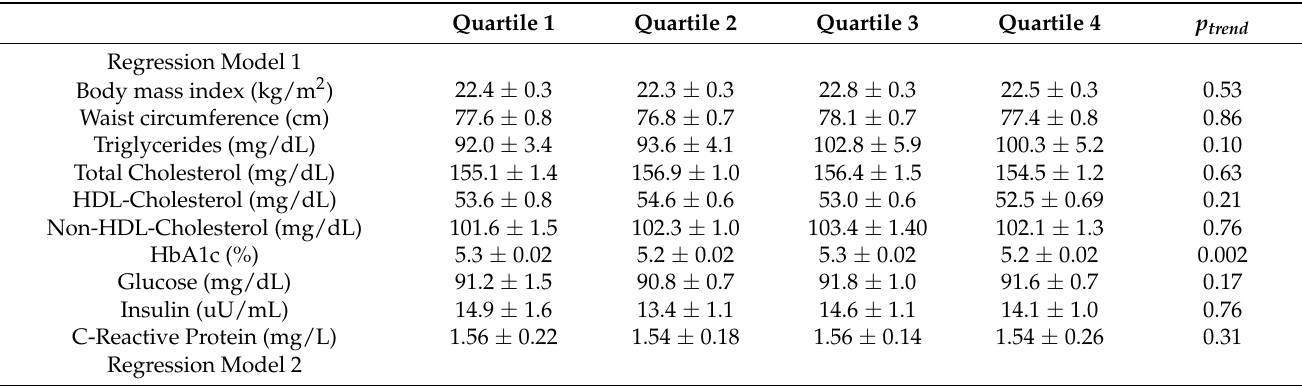
Figure A1. Survey-weighted bubble plot depicting the association between plasma and water fluoride. The size of the bubbles reflects the sum of the weights, with an accumulation at plasma fluoride levels of 0.18 umol/L (limit of detection at 0.25 umol/L divided by the square root of 2); the trend lines were obtained by non-parametric quantile regression placing nine knots equally across the distribution. Table A1. Adjusted mean levels of anthropometric factors and metabolic biomarkers across sex- specific quartiles of plasma fluoride ( n = 3495)